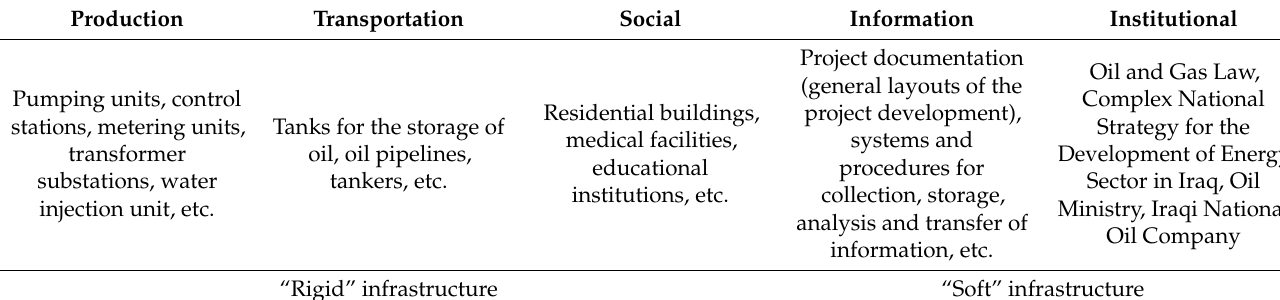
Table 2. Oil industry infrastructure